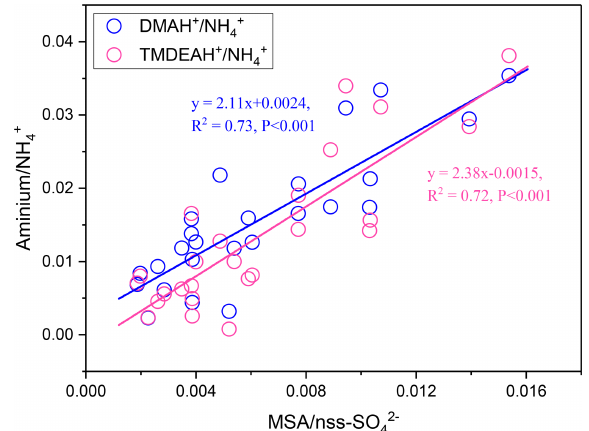
Figure 13. Correlations between aminium / NH + SO 2 − over Huaniao Island during autumn 2016 and summer 4